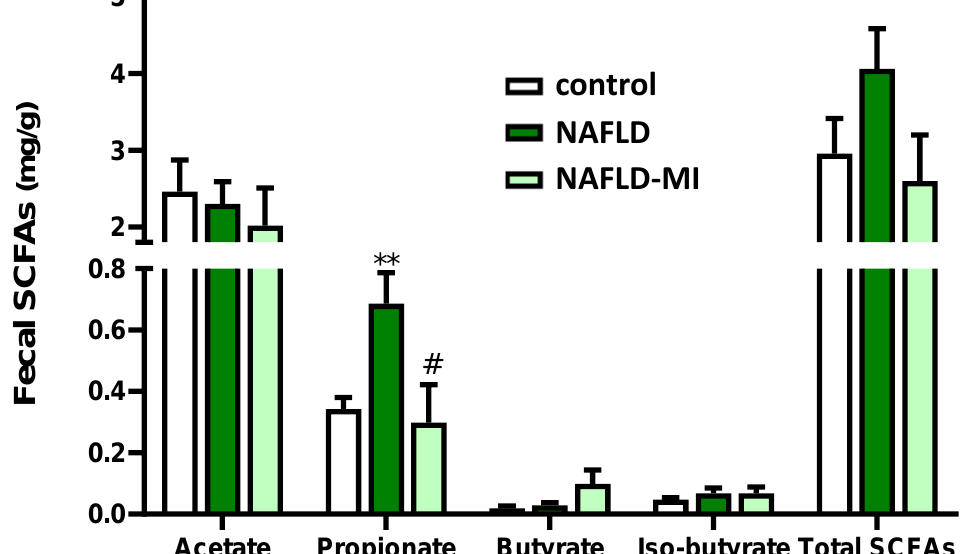
Figure 5. SCFAs quantification in fecal samples. Fecal amounts of the different short-chain fatty acids were analyzed in control, NAFLD, and NAFLD-MI mice. Data are mean ± SEM. ** p < 0.01 vs. control mice; # p < 0.05 vs. NAFLD mice.